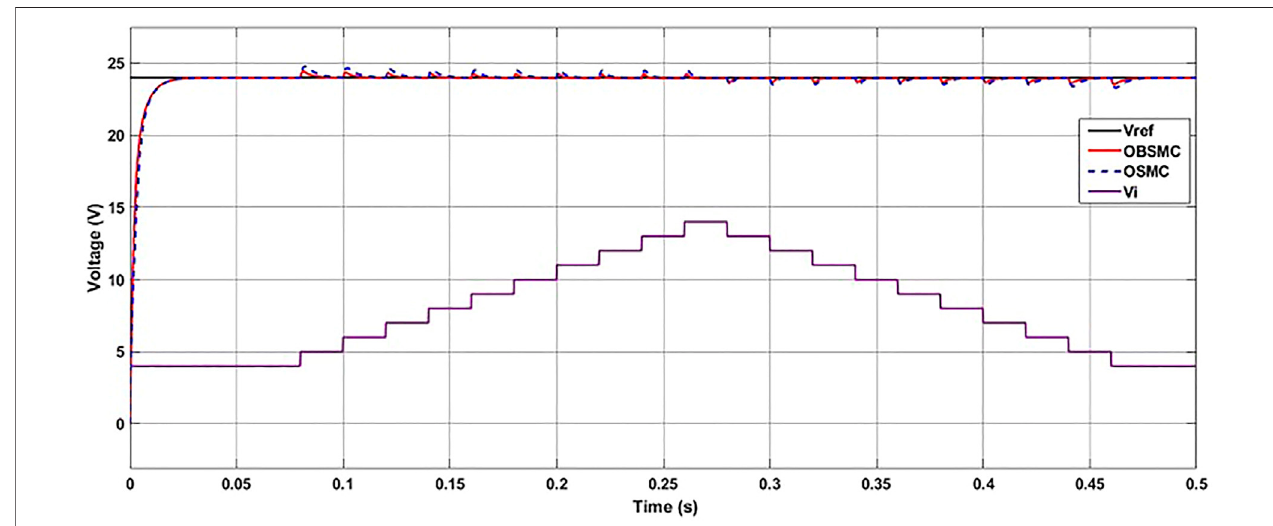
FIGURE 8 | The output voltage of the converter with the greatly varied value of input voltage V i